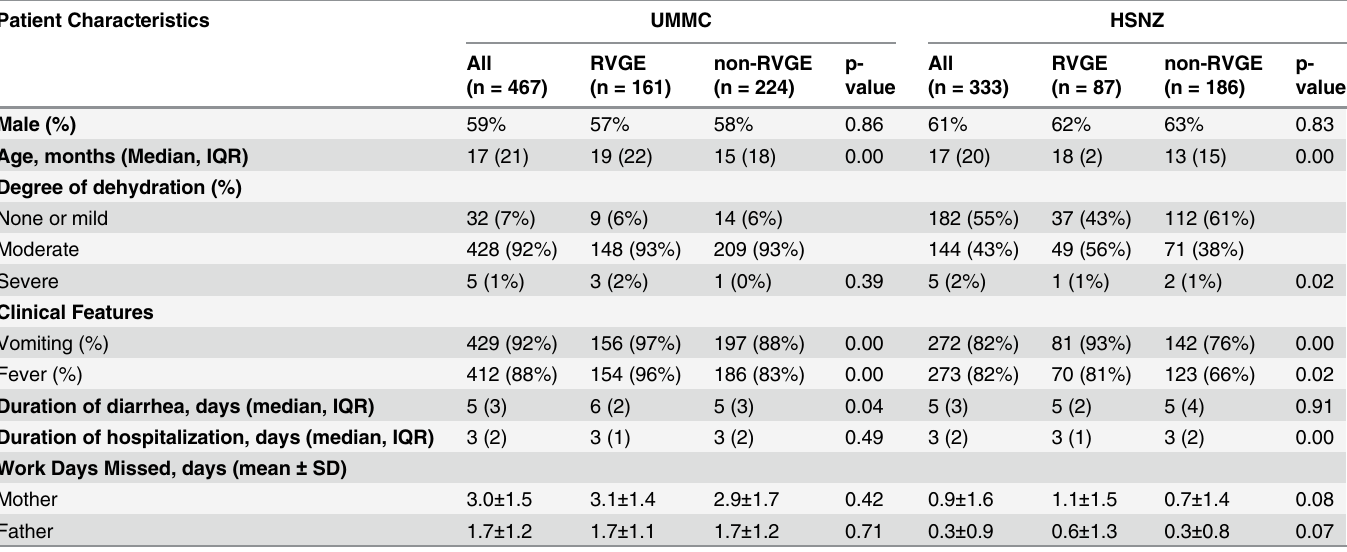
Table 1. Characteristics of children hospitalized for acute gastroenteritis and tested for rotavirus at UMMC, Kuala Lumpur and HSNZ, Kuala Terengganu. Patient